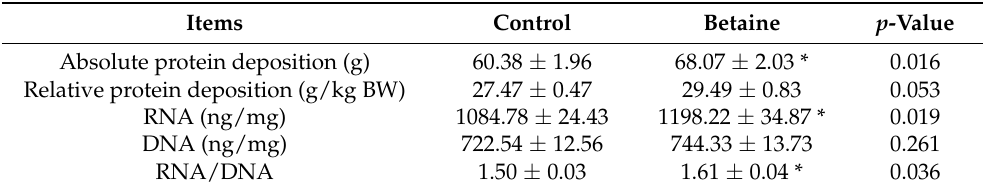
Table 5. Effect of betaine on breast muscle protein deposition and nucleic acids contents of broilers at 52 d of age. Items Control Absolute protein deposition